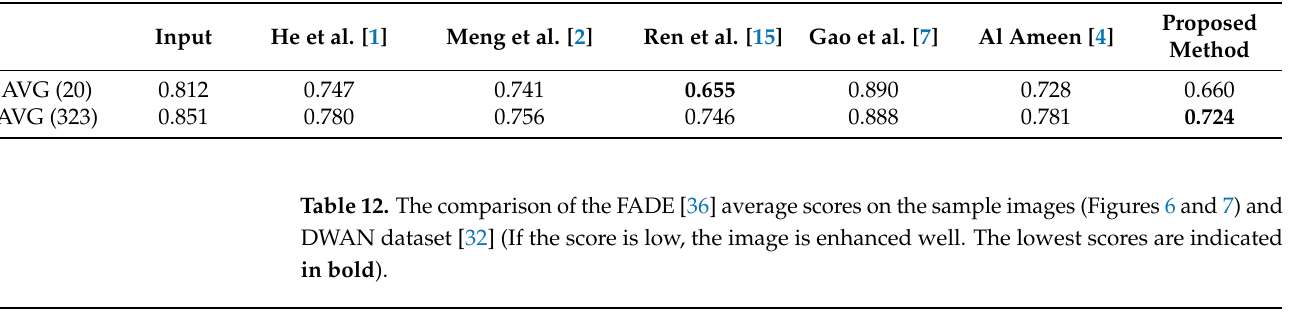
Table 11. The comparison of the HDE [35] average scores on the sample images (Figures 6 and 7) and DWAN dataset [32] (If the score is low, the image is enhanced well. The lowest scores are indicated in bold ).